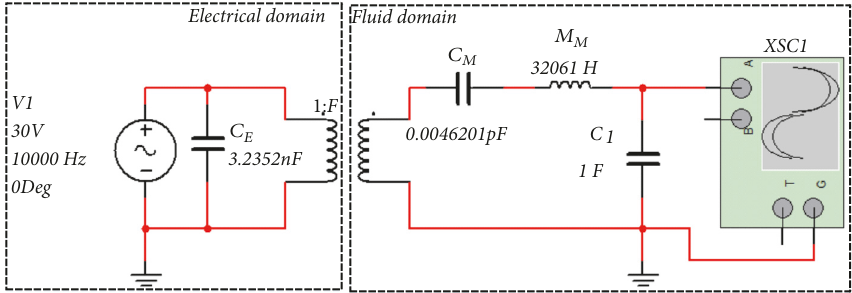
Figure 6: Piezoelectric actuator’s equivalent circuit model.